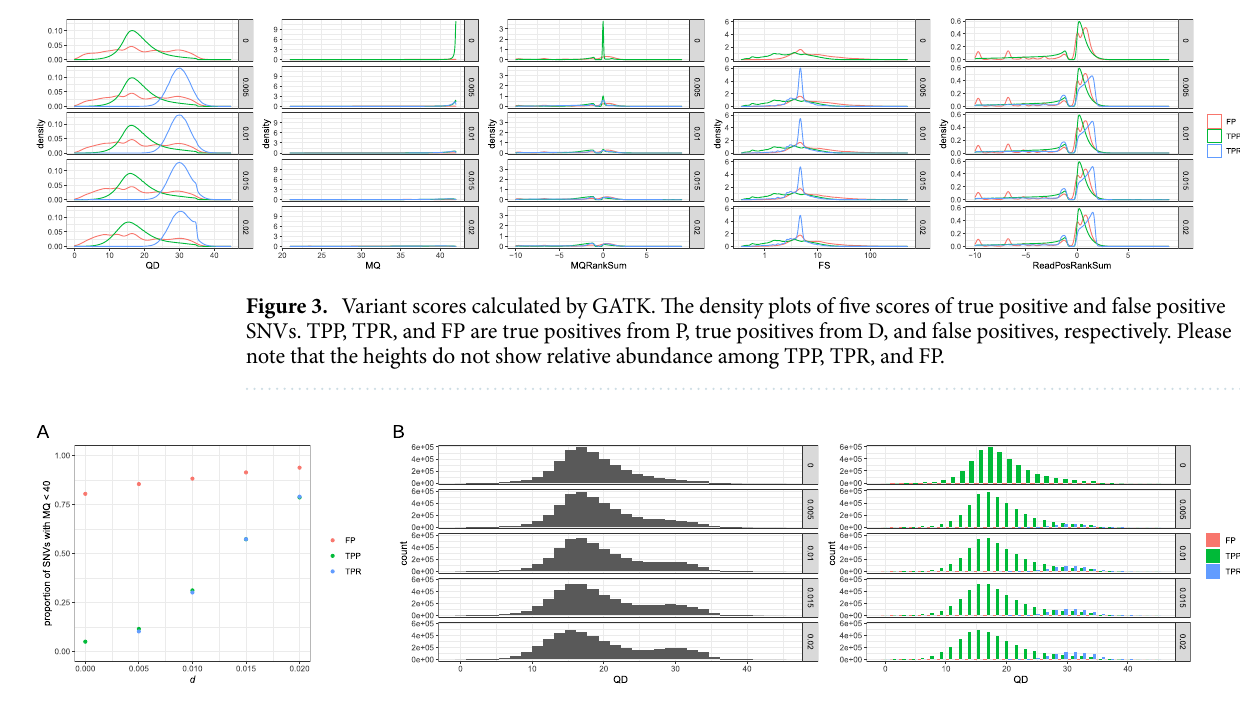
Figure 4. MQ and QD scores in GATK. ( A ) The proportion of TPP, TPR, and FP with MQ < 40 according to d . ( B ) The histograms of QD scores (left) from all SNVs and (right) from TPP, TPR, FP,